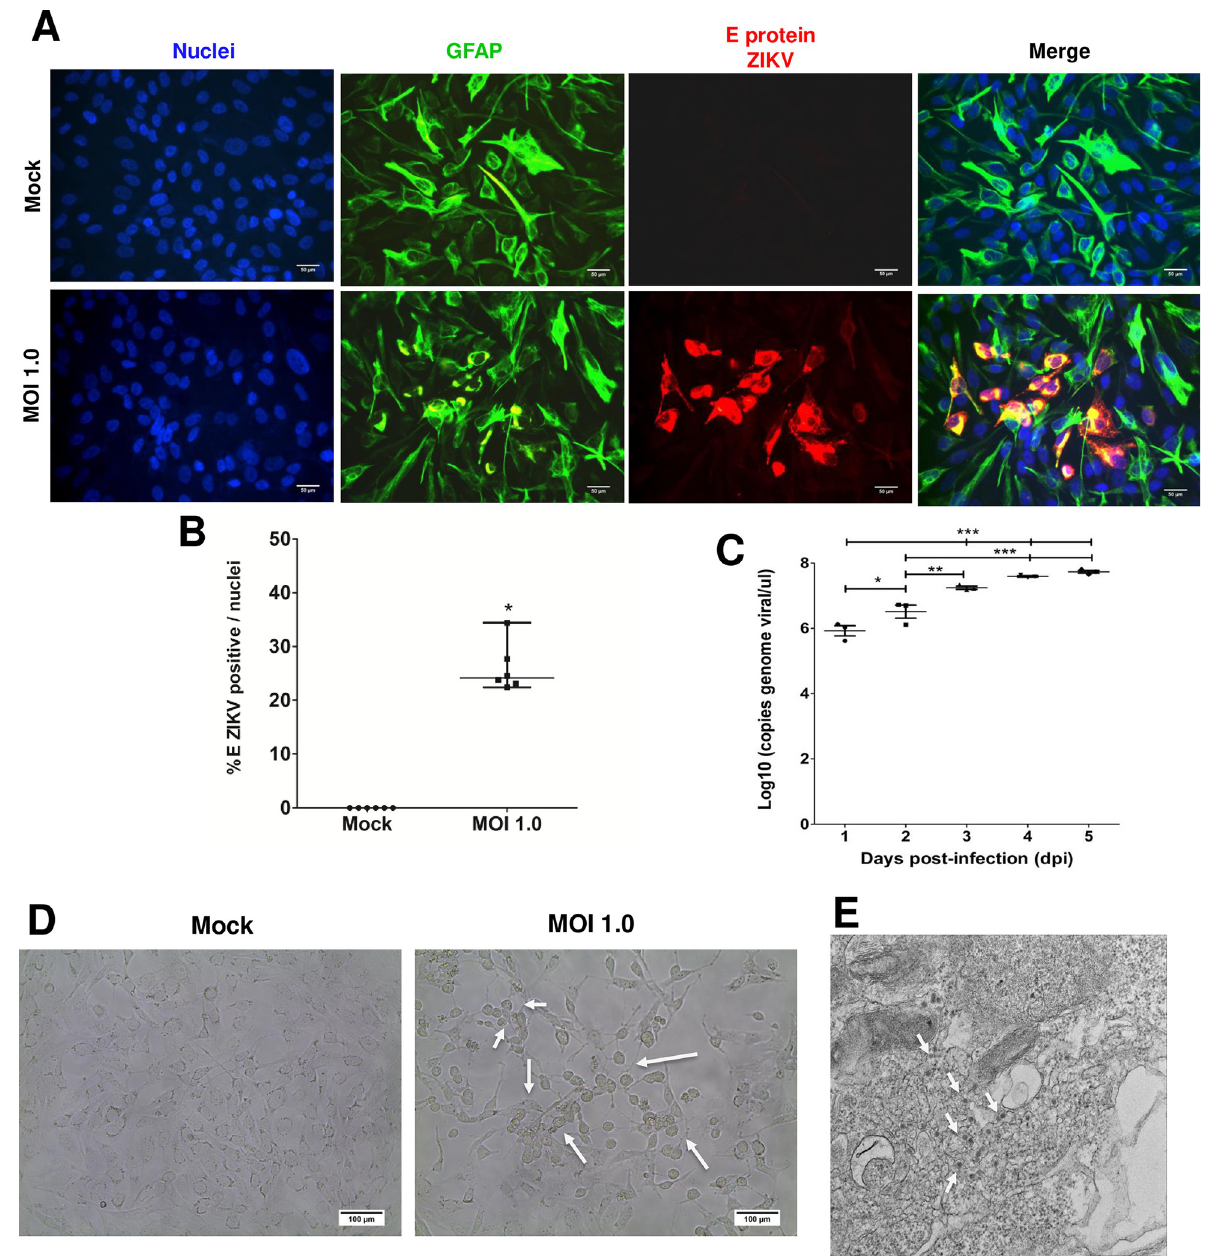
Fig 2. Astrocytes-hNS1 are permissible and susceptible to ZIKV infection. (A) The astrocytes-hNS1 were seeded in 24-well plates and processed for immunofluorescence with antibodies against GFAP (green) and ZIKV envelope protein (red), and the nuclei were stained with Hoechst (blue). Scale bar 50 μ m. (B) The number of cells positive for ZIKV infection was quantified at three dpi with MOI of 1 (mean percentage and standard deviation, n = 6, p = 0.031, t-test). (C) The Astrocytes were infected with ZIKV (MOI of 1), and supernatants were recovered for 5 dpi to determine viral genome production by qRT-PCR. An increase in the viral genome during the infection progress is shown ( * p < 0.05, ** p < 0.01, *** p < 0.001, ANOVA with Tukey’s multiple comparisons). Each point represents the mean of 3 independent experiments with at least two duplicates, and the error bars correspond to the standard deviation. (D) Brightfield microscopy of ZIKV infected (MOI of 1) or mock-infected astrocytes-hNS1 at 5 dpi. Scale bar 100 μ m. White arrows indicate cytopathic effect (E) Thin-section TEM of infected cells (MOI of 1) at 6 dpi shows the presence of viral particles inside vesicles (white